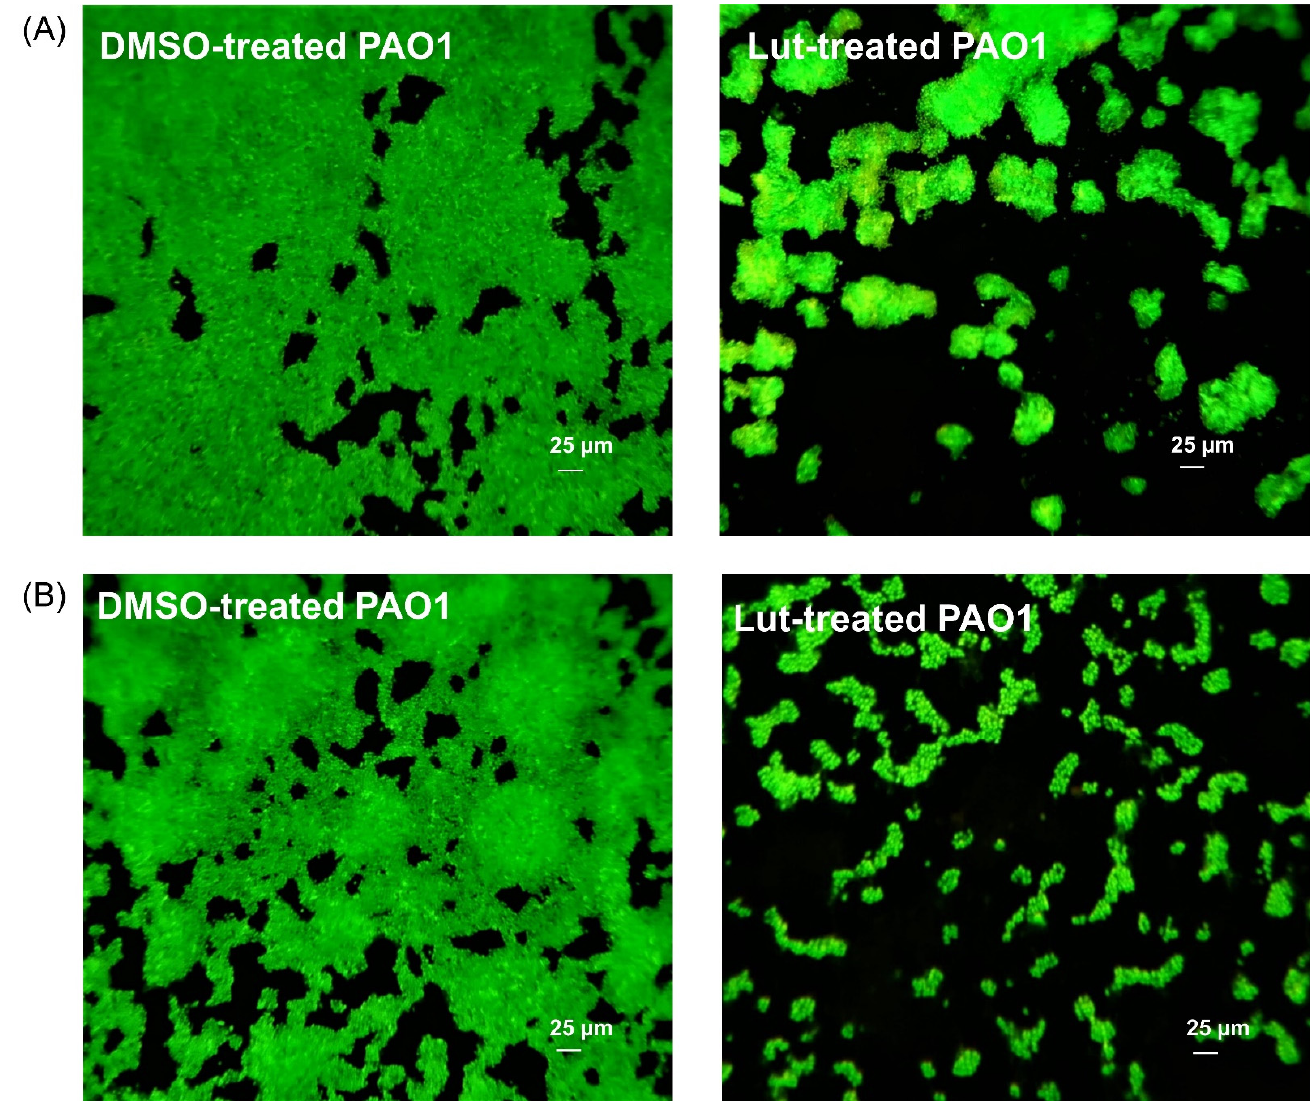
Figure 4. PAO1 biofilm phenotypes as affected by Lut. ( A ) Effect of Lut on biofilm development in which PAO1 cells were incubated statically at 37 °C for 24 h in presence of DMSO 1%, or Lut at 22 µM. ( B ) Effect of Lut on one-day-old preformed biofilm in which PAO1 cells were incubated for 24 h and then treated for 24 h with DMSO 1%, or Lut at 22 µM. Cells were visualized after staining with SYTO-9 (LIVE/DEAD BacLight kit) in which green fluorescence color represents living cells. Fluorescence microscopy was achieved by using an epifluorescence microscope coupled to Sony L2 camera using a 40× objective lens, and images were false colored using Microsoft Photos software.